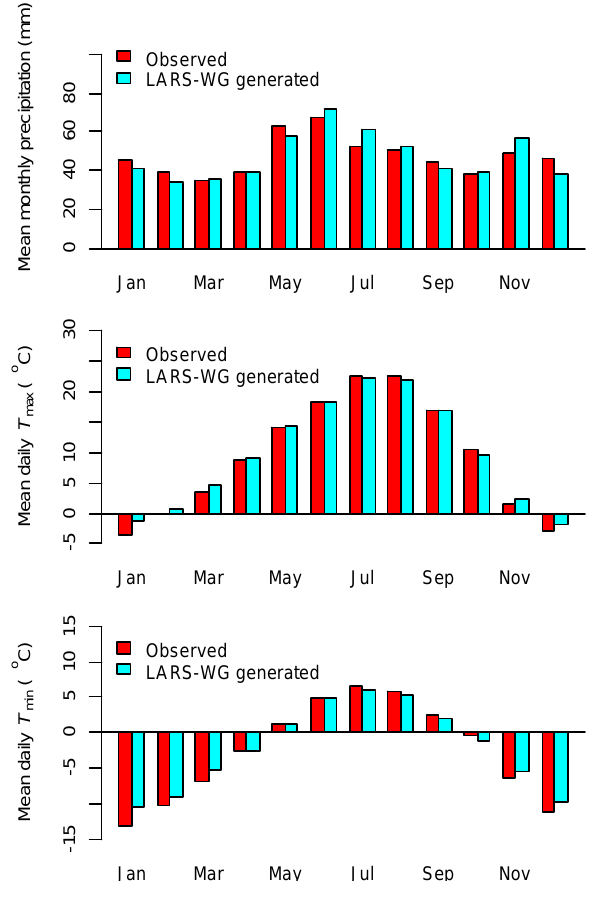
Fig. 3. Observed and LARS-WG-generated mean monthly precipi- tation, and monthly mean daily T max and T min